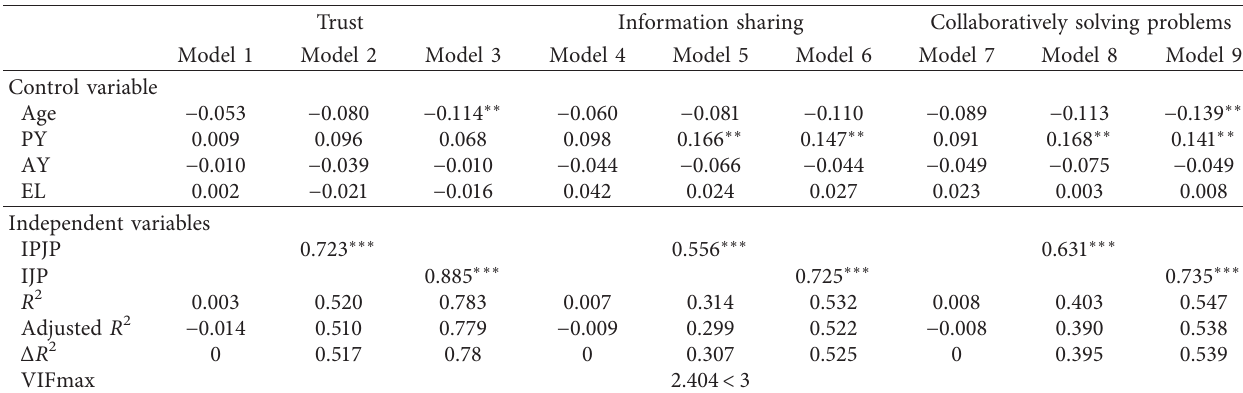
Table 5: Regression analysis of the influence of interactive fairness on relational embeddedness.